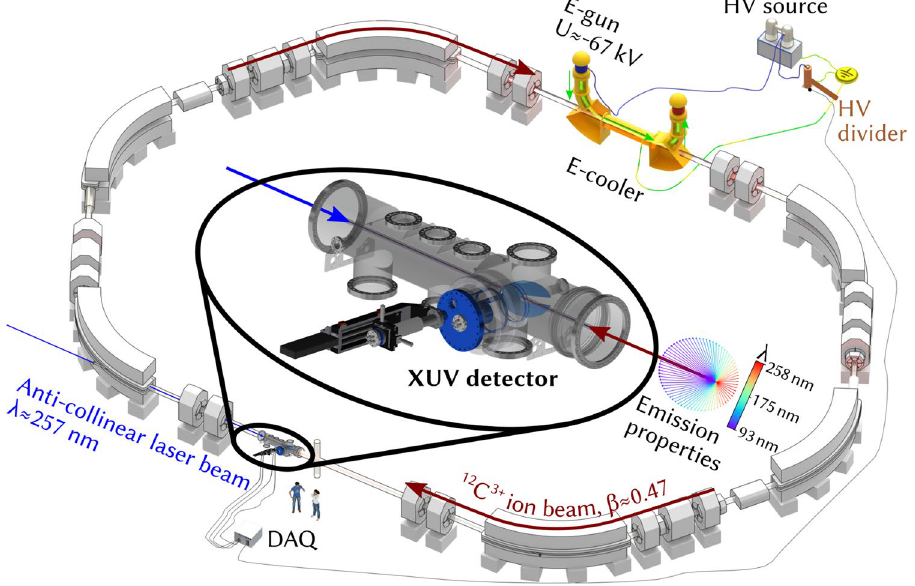
Figure 1. Schematic view of the ESR with an enlarged view of the optical detection region. The ion beam is circling clockwise in the ring while the laser beam is counterpropagating with the ions inside the straight section of the ESR (figure adapted from 12